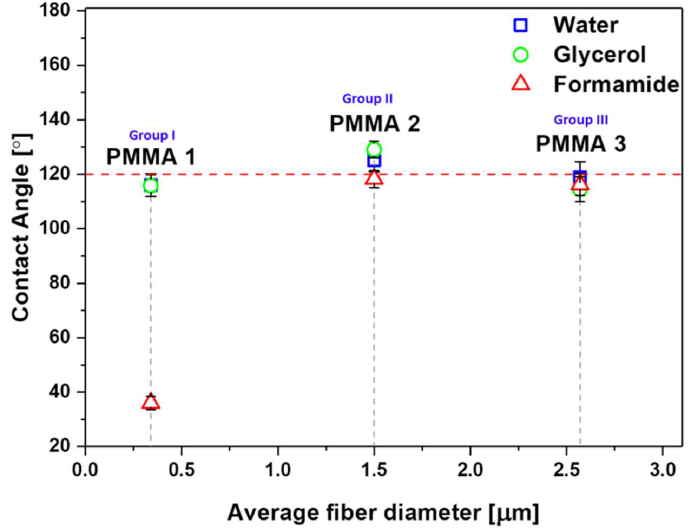
Figure 4. The contact angle for water, glycerol, and formamide on PMMA mesh with three sets of D f : PMMA 1—0.34 µm, PMMA 2—1.43 µm, PMMA 3—2.57 µm. Table 4. The thickness of electrospun samples from PMMA 2 fibers with characteristic electrospinning time and all other characteristic parameters, such as D f , R a , F f , and contact angles with water, glycerol, and